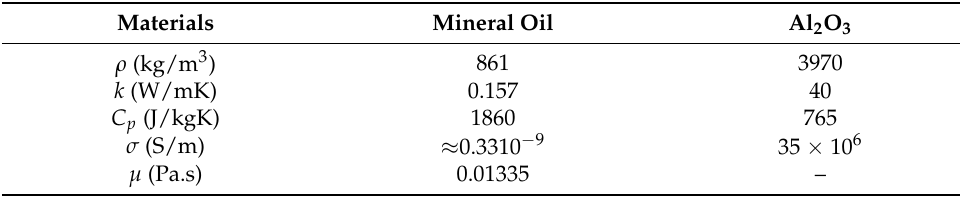
Table 2. Thermo-physical properties of mineral oil and nanoparticles